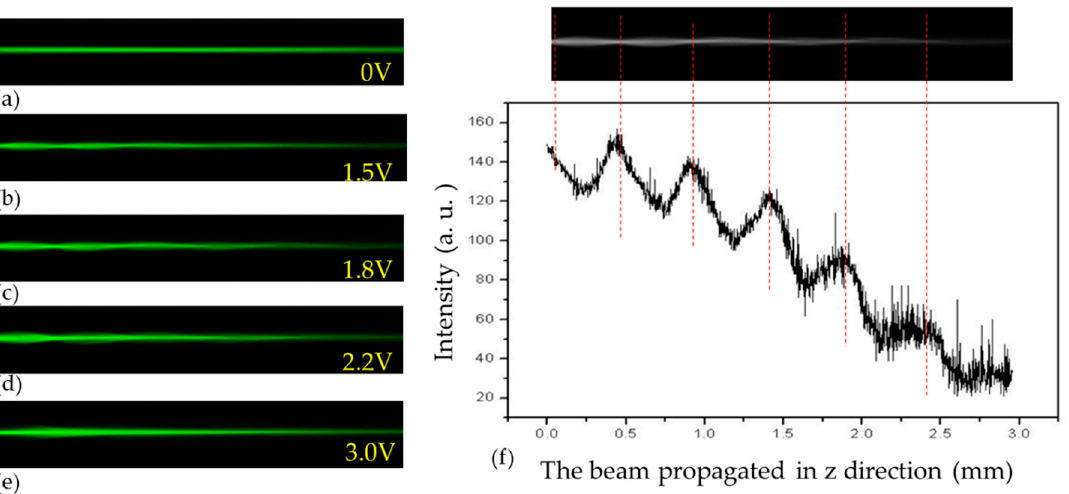
Figure 3. The evolution of the self-focusing in a single channel with the applied voltages of ( a ) 0, ( b ) 1.5, ( c ) 1.8, ( d ) 2.2, and ( e ) 3 V. ( f ) The propagation of laser beam in a single channel with the applied voltage of 1.8 V and the corresponding intensity distribution.